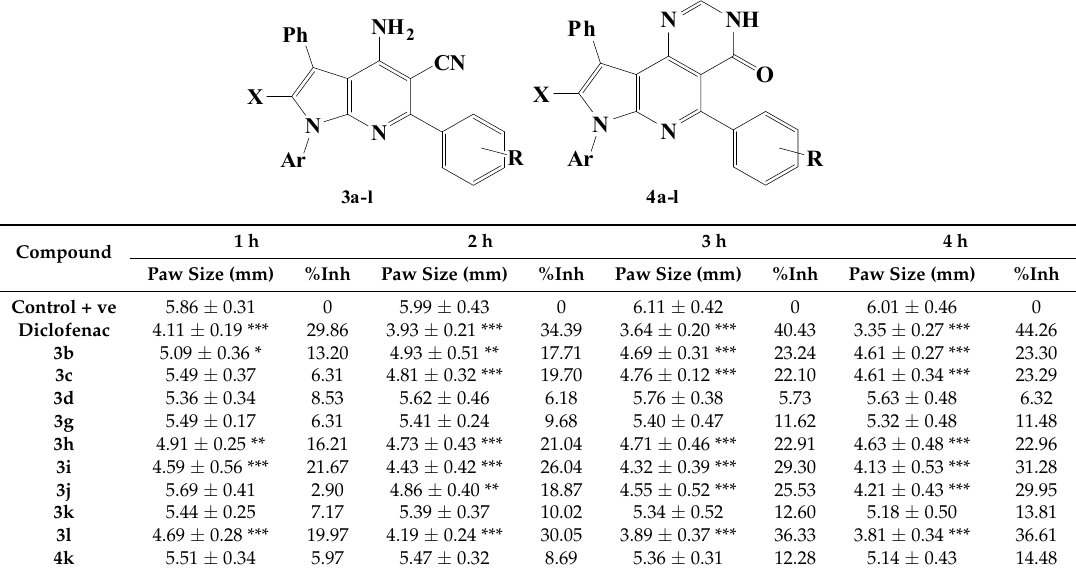
Table 2. Anti-inflammatory activity of tested compounds, Results shown in paw size (mm, mean ± SD) and % inhibition over tested periods in comparison with control and standard drug.